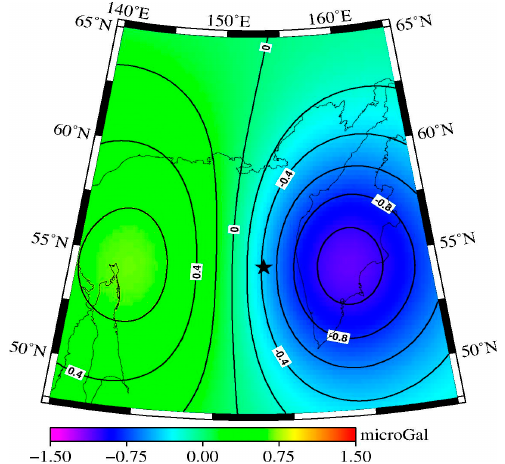
Figure 4. The spatial distribution of the coseismic gravity changes obtained by the elastic dislocation theory [26] in a spherical earth model after sea water correction and truncating the degree/order to 60 and applying the P4M6 decorrelated filter and 350 km Gaussian smoothing. The contour and contour-annotated intervals are 0.2 microgal and 0.4 microgal, respectively. The black star represents the location of the epicenter.